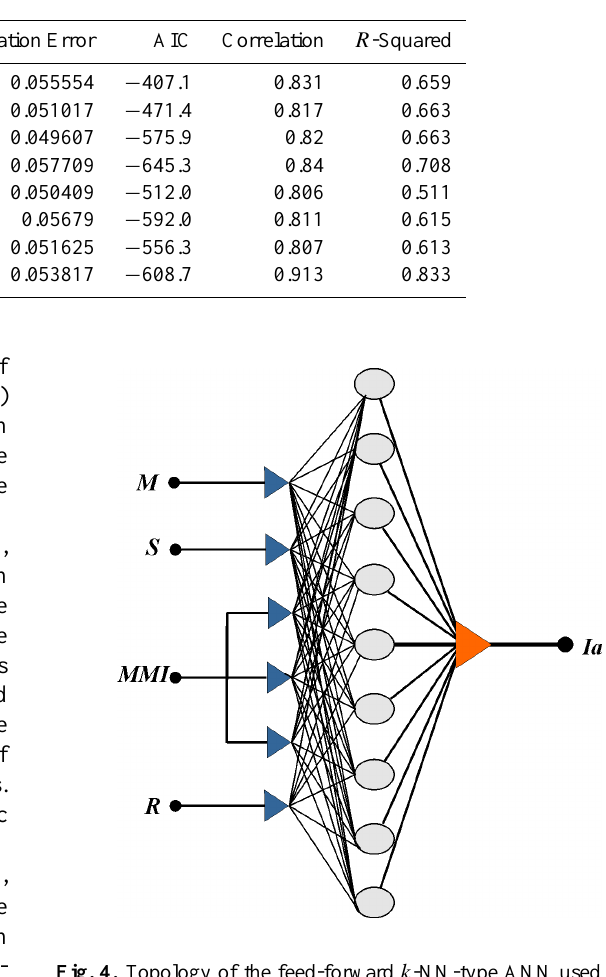
Fig. 4. Topology of the feed-forward k -NN-type ANN used in the present study. Input parameters are magnitude M w , Soil parameter S , MMI and epicentral distance R